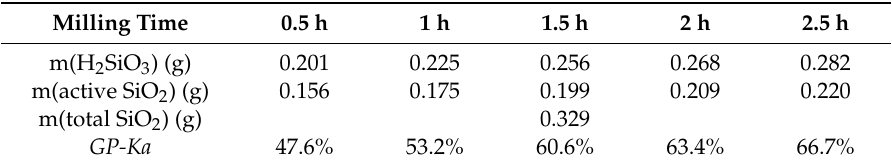
Table 7. Percentage of active SiO 2 of GP.